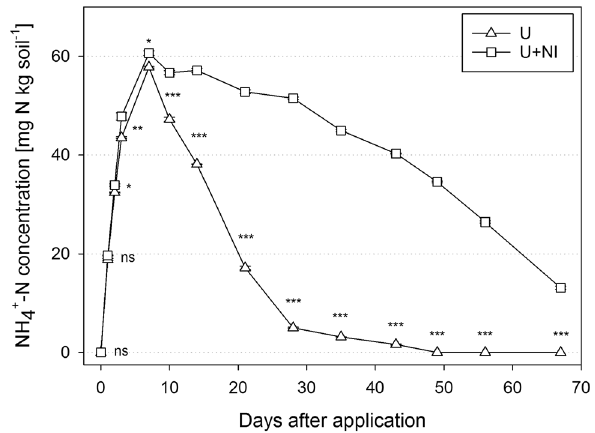
Figure 1. Temporal change of NH 4+ -N concentration under standardised conditions for treatments urea (“U”, triangle) and urea with nitrification inhibitor (“U+NI”, square) in soil extract (1 M KCl). Asterisk indicates significant difference between treatments at p < 0.05 (*), p < 0.01 (**) and p < 0.001 (***), ns = not significant. Error bars are masked by treatment symbols in most cases.